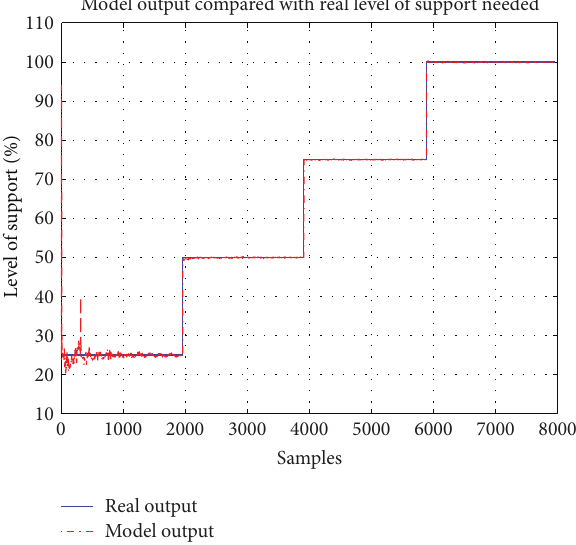
Figure 8: Modelling of the support function of the orthosis, experiment 1. The level of support is only calculated for the upward direction.